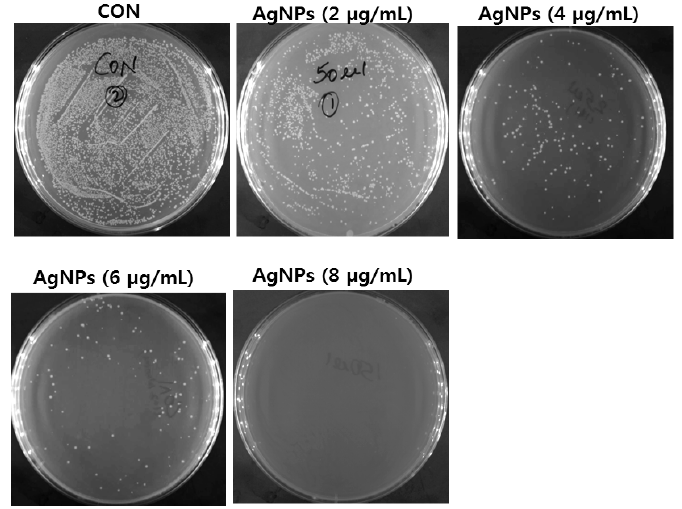
Figure 4. Dose-dependent antibacterial activity of biologically synthesized AgNPs in E. coli. CON: